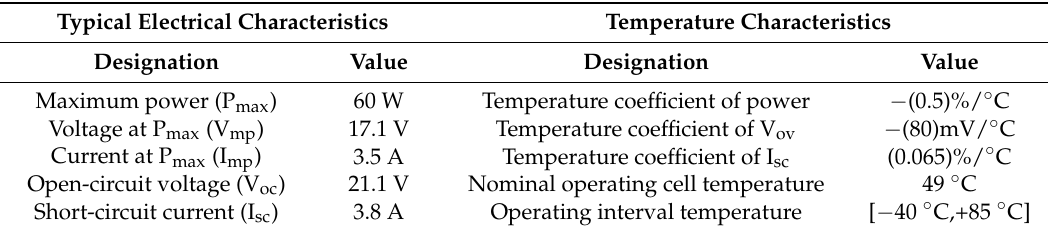
Figure 11. Photo of the experimental test bench. Table 3. Manufacturing PV module parameters of Solarex MSX-60.